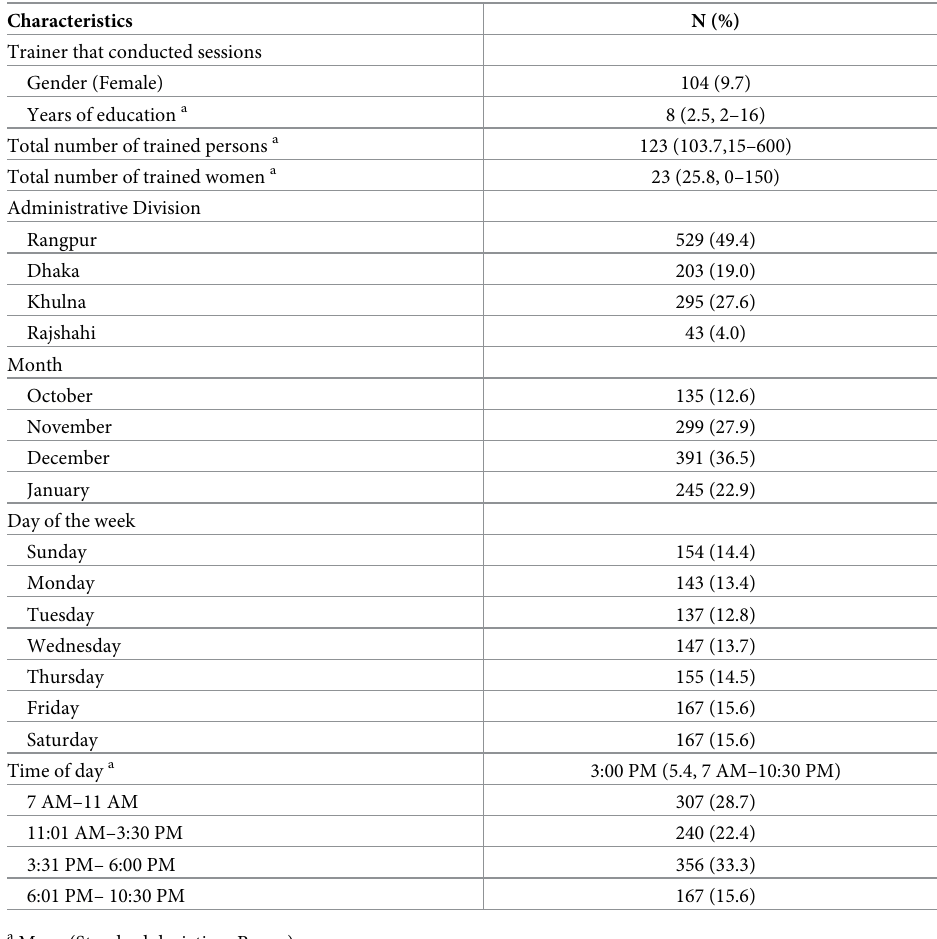
Table 1. Descriptive statistics of the 1070 training events b